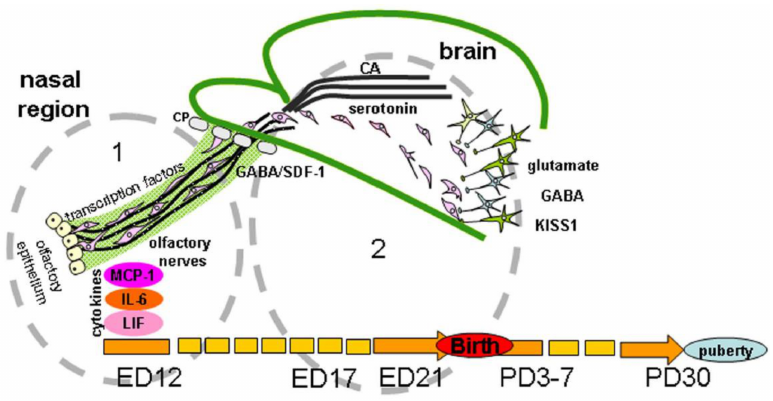
Figure 2. Regulation of gonadotropin-releasing hormone (GnRH) neuron migration in nasal region (1) and brain (2) during development. GnRH neurons originate outside the brain in nasal olfactory epithelium and later neurons migrate using the surface of olfactory/terminal/vomeronasal nerves through the cribriform plate of the ethmoid bone (CP) to the forebrain on embryonic days (ED) 11-15 in mice and ED 12-17 in rats. Their migration is orchestrated by different signal molecules, such as cell adhesion molecules (polysialylated neural cell adhesion molecules (NCAM) in rats or peripherin in mice), soluble guidance-cue factors (semaphorins, Slit proteins, netrins, reelin, stromal cell-derived factor 1 (SDF-1), etc.), cytokines (monocyte chemoattractant protein-1 (MCP-1), interleukin-6 (IL-6), leukemia inhibitory factor (LIF)), neurotransmitters (gamma-aminobutyric acid (GABA), glutamate, monoamines (serotonin, catecholamines (CA)), and transcription factors (Pax6, AP-2 α , Gli3, Ebf2 Nhlh2 VAX1 Mash-1, Math4A, Math4/neurogenin1, NeuroD, Olf-1, GATA-4). In rats, GnRH-neurons reach their final position on ED19 and after the receiving of correct afferent innervation they are capable of performing main function—to regulate the reproductive axis in adults. The same signal molecules can perform different functions or other molecules can be included at different stages of the development of the GnRH system. For instance, NCAM apparently participate in laying the route for GnRH neurons and do not play a key role in their migration. Transcription factors are involved in the initial stages of the differentiation of olfactory placodes and the precursors of GnRH neurons, cytokines in the development of olfactory structures and in the migration of GnRH neurons and GnRH secretion. Neurotransmitters take part in the migration of GnRH neurons mainly at the stage of their entry into the forebrain. Guidance-cue molecules are involved in the development of the olfactory system and contribute to directing the migration of GnRH neurons in the nasal head region and forebrain. Kisspeptin (KISS1) signaling is well demonstrated as a key component for the onset of puberty, GnRH neurons express KISS1 in embryonic mice brain. Moreover, KISS1 may inhibit GnRH neuronal movement and plays a role of stop molecule for GnRH neuronal migration. Abbreviation: PD—postnatal